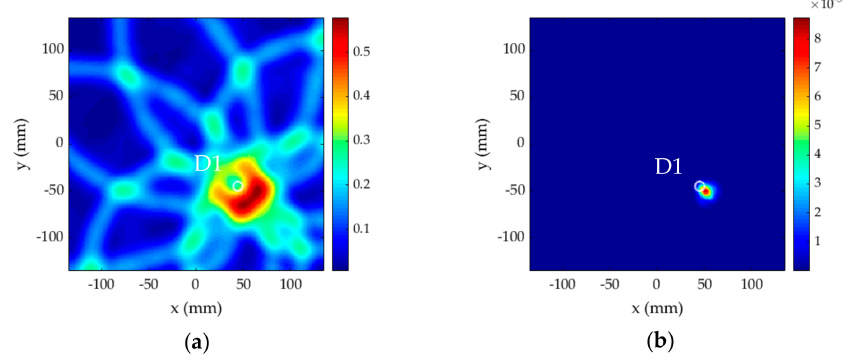
Figure 11. Aggregate damage image for single damage scenario in pulse–echo configuration based on ( a ) compromised fusion scheme; ( b ) conjunctive fusion scheme.